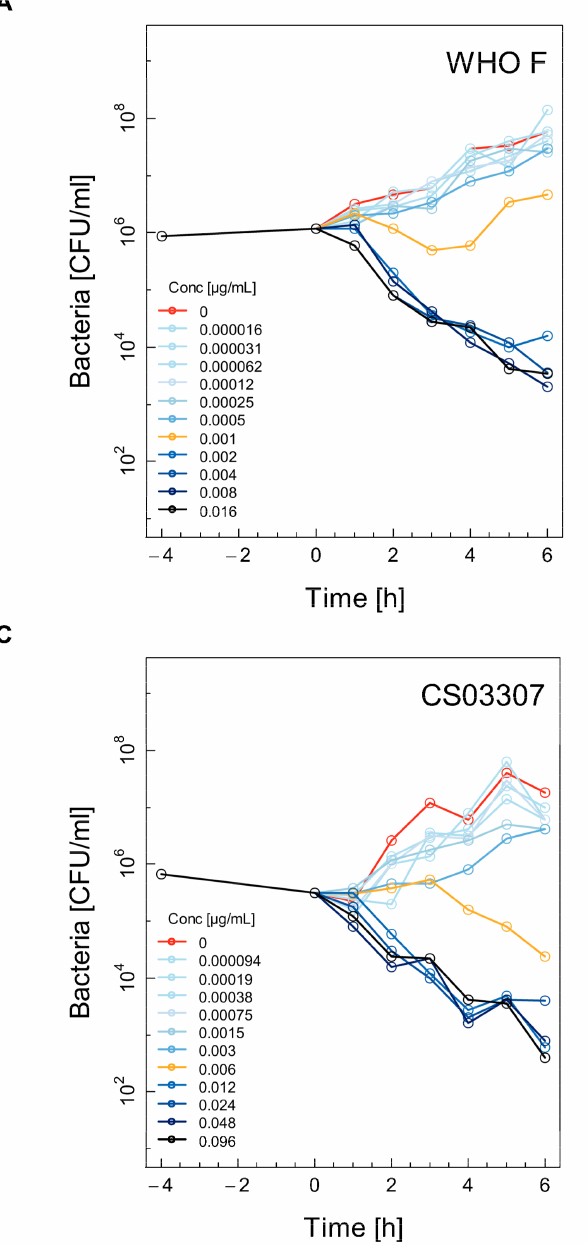
Figure 2. Selected time–kill curves (TKC) for three different strains of Neisseria gonorrhoeae using ertapenem. For each combination of antibiotic and strain, the TKC from one of the three independent experiments is shown: WHO F ( A ), WHO X ( B ), CS03307 ( C ). See the legend for Figure 1 for further